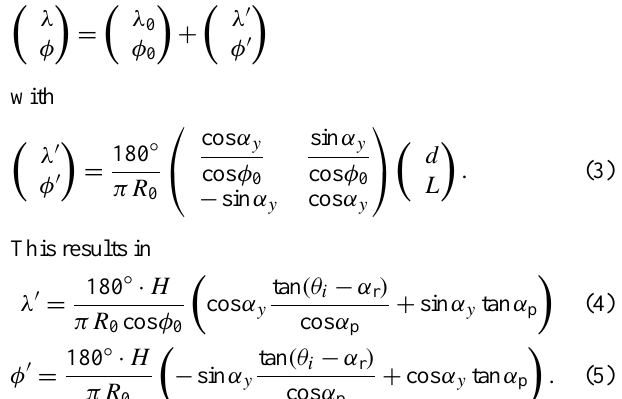
Figure 3. Demonstration of the good performance of the geoloca- tion determined from the instrument field of view and correction by the aircraft angles during a curve. The recorded light intensity (left) shows high reflectivity of the motorway also seen in the Google Earth image (right, www.google.com/earth). The motorway is ob- served by a composite of three differently oriented overpasses and appears continuous and in the correct